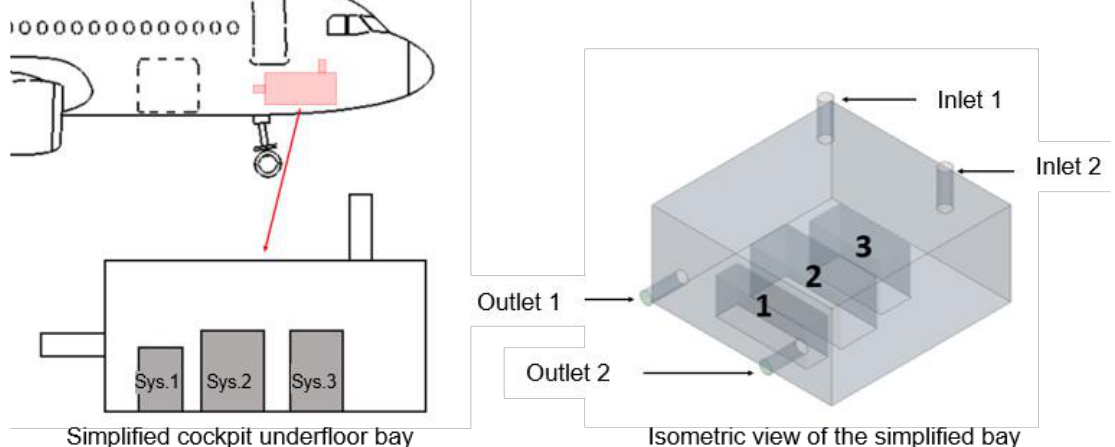
Figure 2. Cockpit underfloor equipment bay in a larger commercial aircraft and derived simplified bay model with three cubic-shaped systems (Configuration 1).